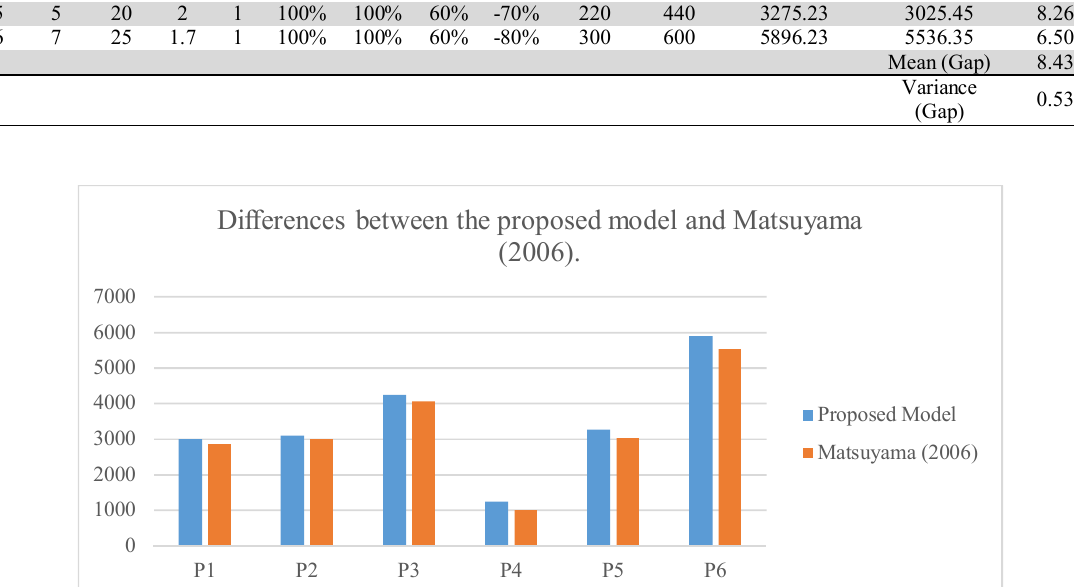
Fig. 8. Chart of Differences between the proposed model and Matsuyama